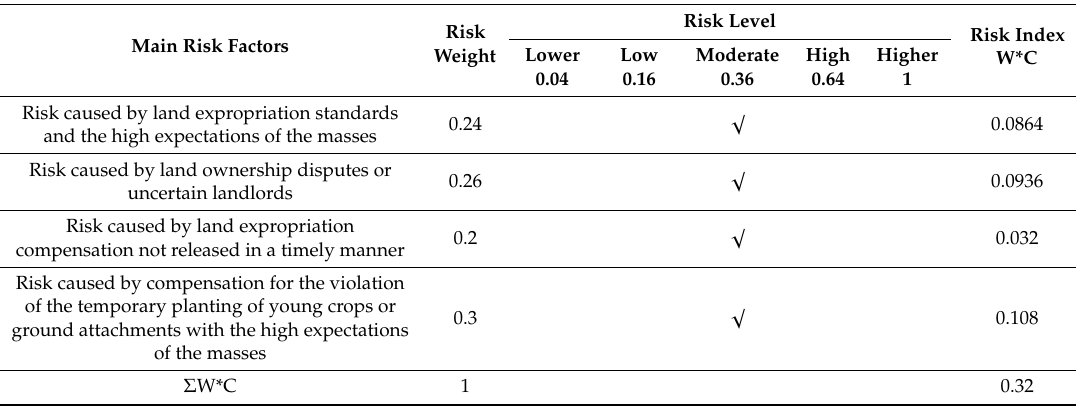
Table 6. Comprehensive risk index quantitative calculation